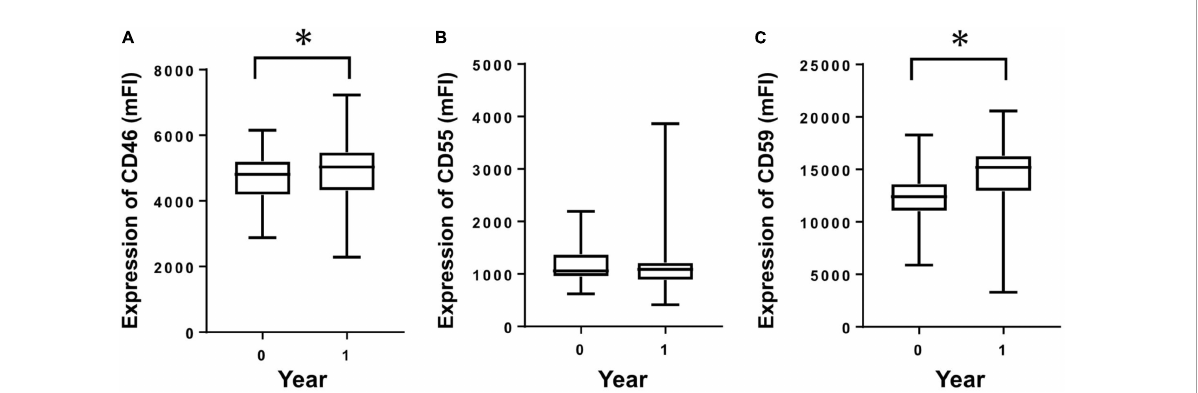
FIGURE2 Expression of membrane complement regulators (CRegs) on human peritoneal mesothelial cells of PD patients during 1 year. Expressions of CRegs CD46 (A) and CD59 (C) were significantly increased during 1 year of observation. Expression of CReg CD55 (B) was not significantly changed. ∗ P < 0.05.